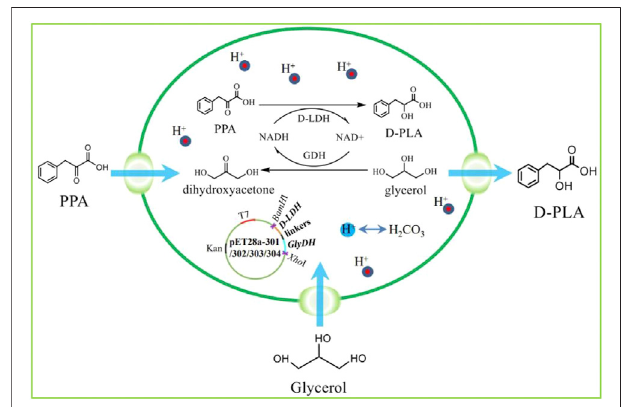
FIGURE1| Theprogramofredoxself-balancedcoenzymeregeneration and whole-cell synthesis of